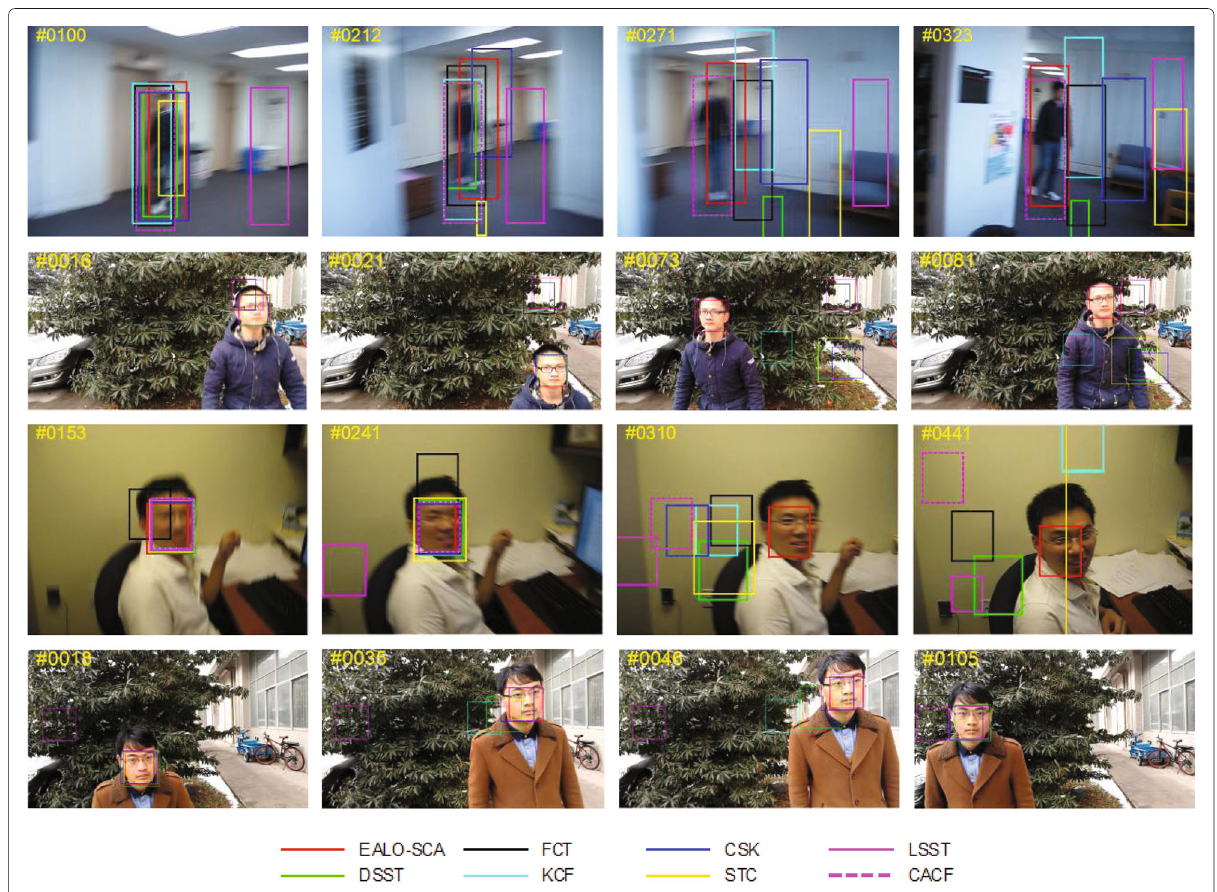
Fig. 12 The tracking results with the large motion. Sequence 1-4: BLURBODY, FHC, BLURFACE, ZT